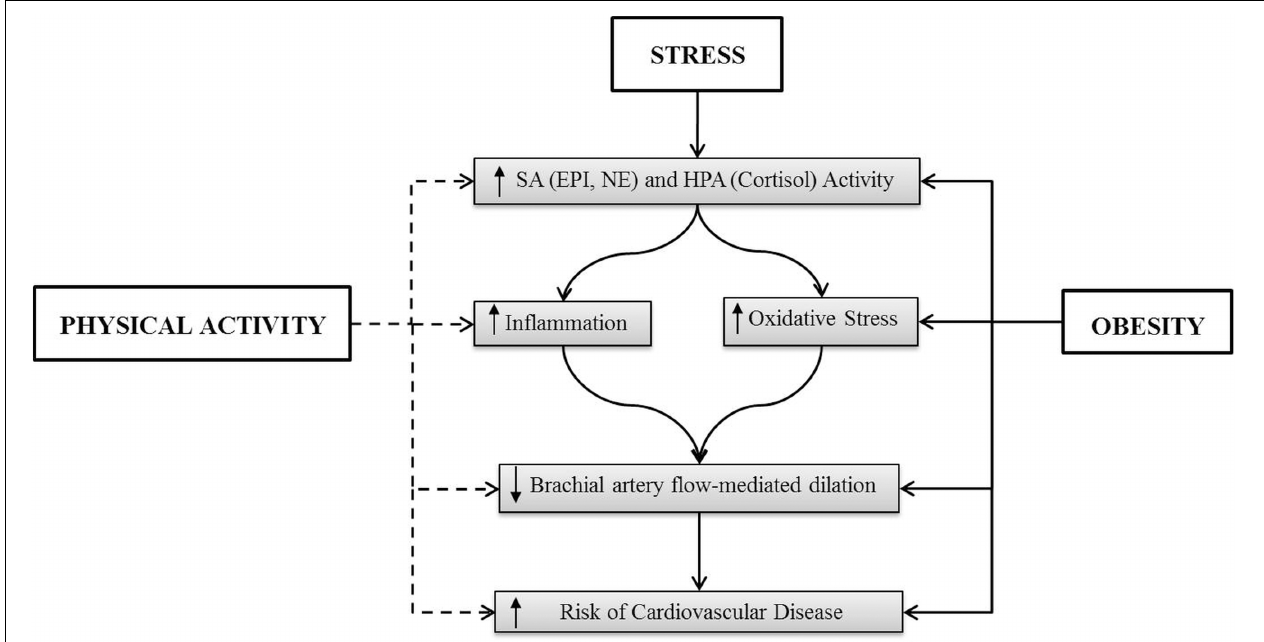
FIGURE 1 | The solid line indicates an activation of the indicated factor and the dashed line represents the suppression of the indicated factors. The effect of stress in obesity has not been